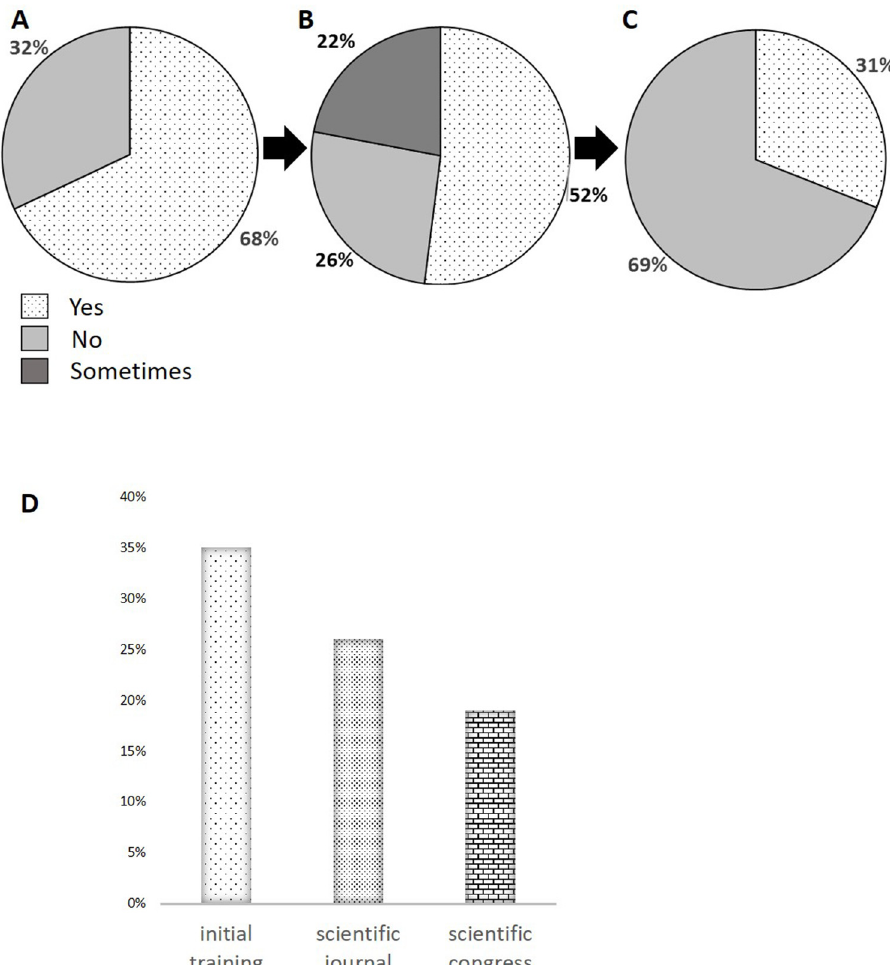
Fig. 3. Knowledge of the ANSM guidelines, adherence claims and actual prescription habits. (A) Frequency of self-reported knowledge of the guidelines and (D) origin of the knowledge (in percentages). (B) Frequency of self-reported adherence to the ANSM guidelines for fi rst line